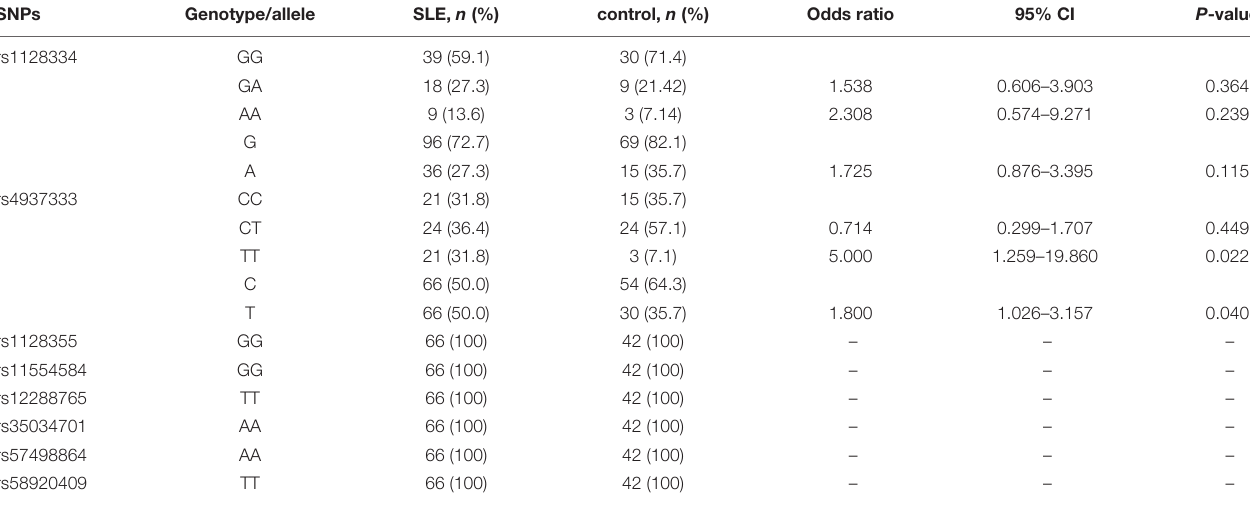
TABLE 1 | Genotype and allele association analysis of SNPs in the ETS1 3 (cid:48) -UTR in the Kunming population.